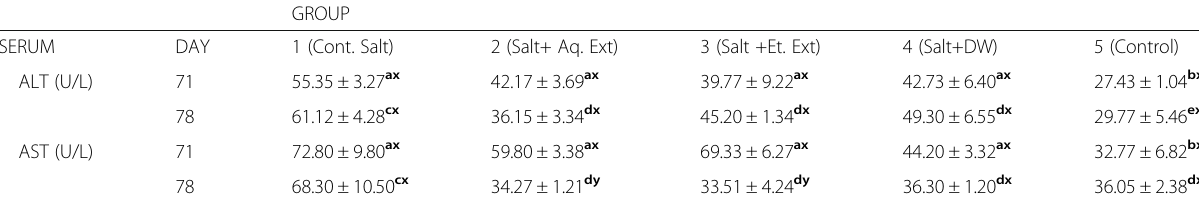
Table 3 The effects of oral administration of extracts (aqueous or ethanol) of A. wilkesiana leaves on Serum ALT and AST activities of salt-loaded